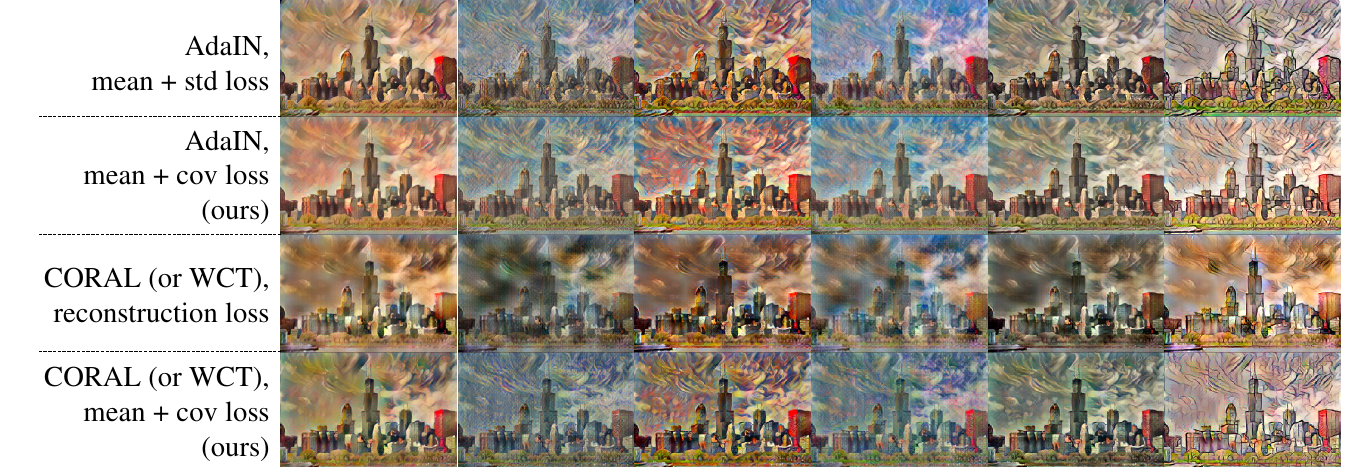
Figure 3. Style-transferred images into several unseen styles with networks trained on a large style